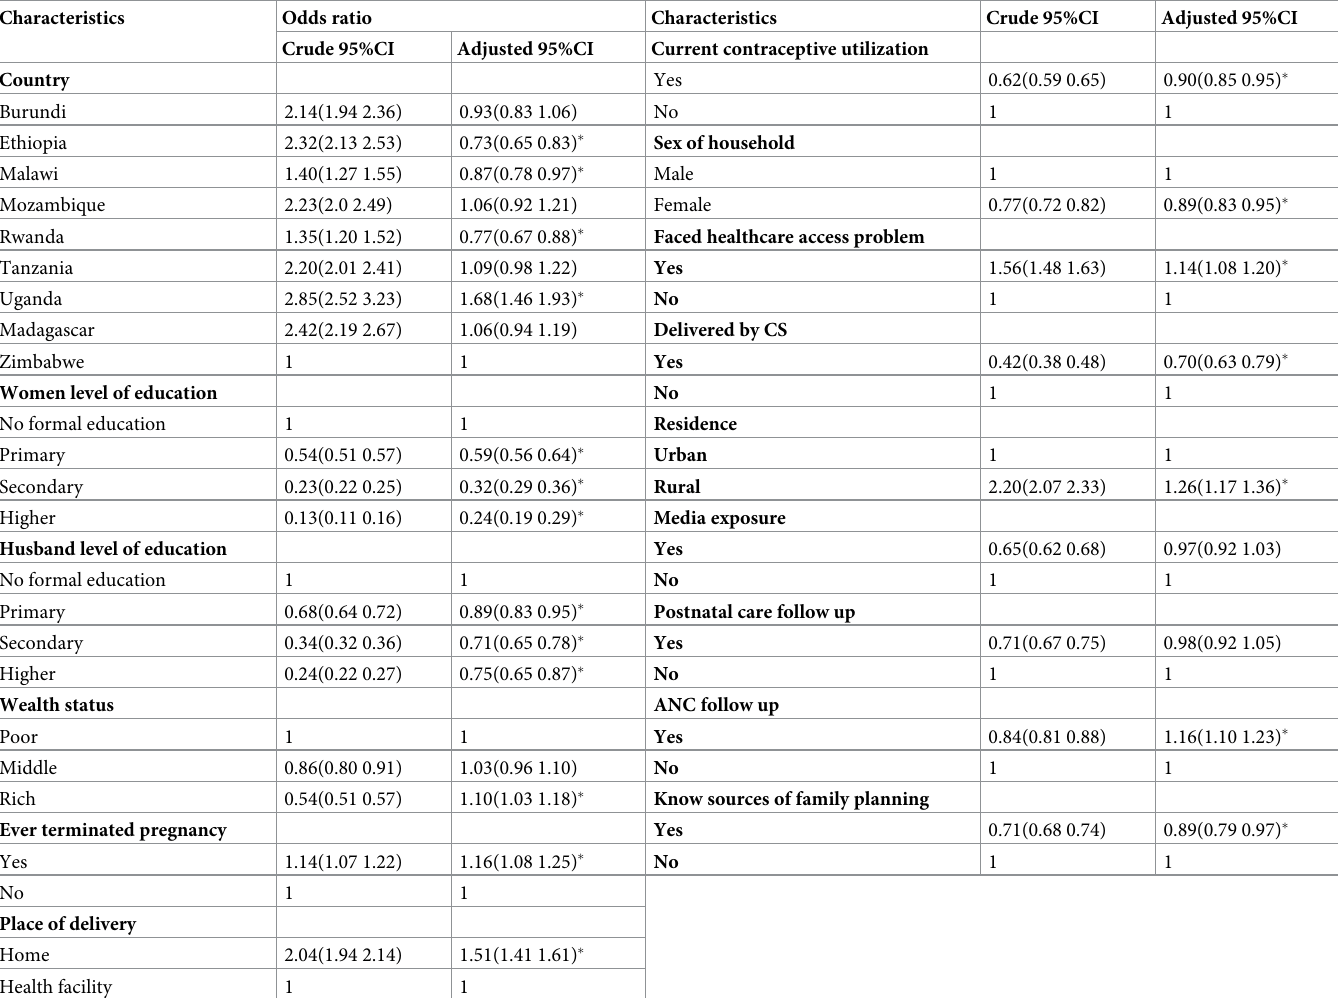
Table 4. Factors associated with high-risk fertility behavior among women gave birth in east Africa region.